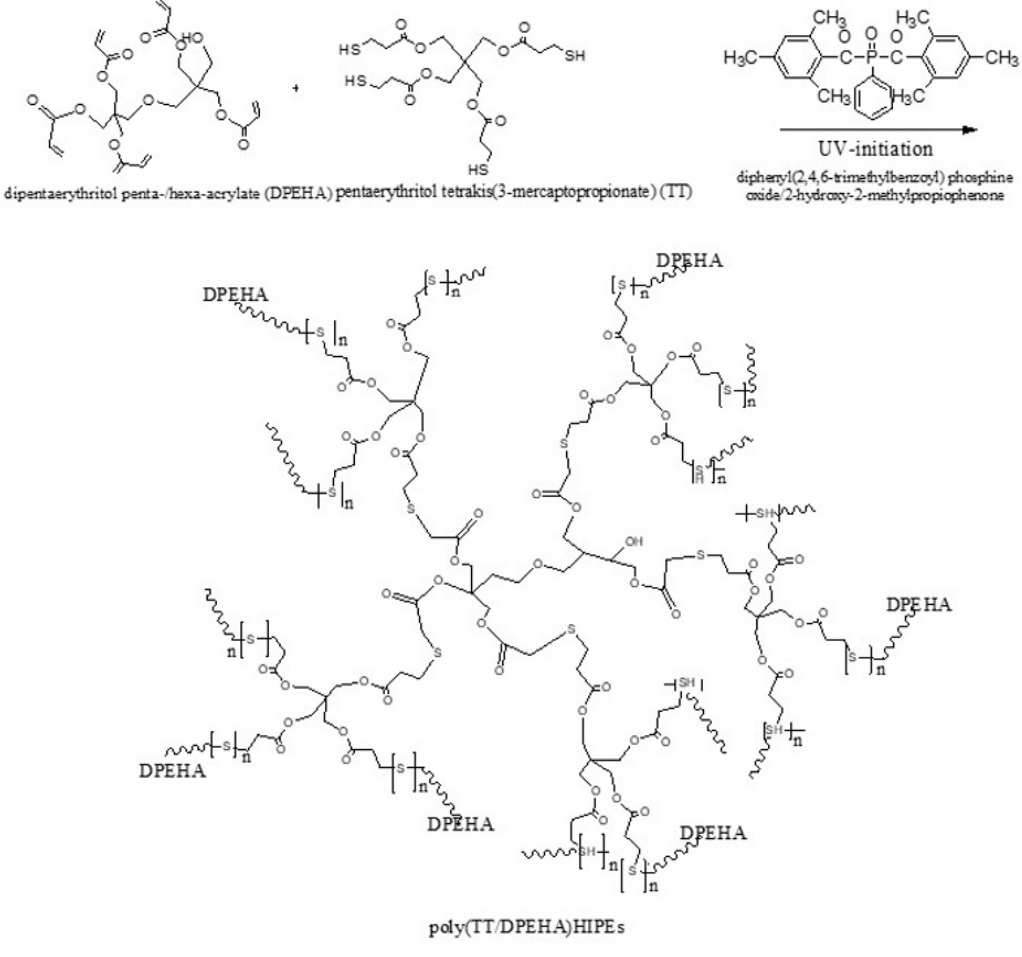
Figure 1. Schematic of poly(TT/DPEHA)HIPEs molecular structure.